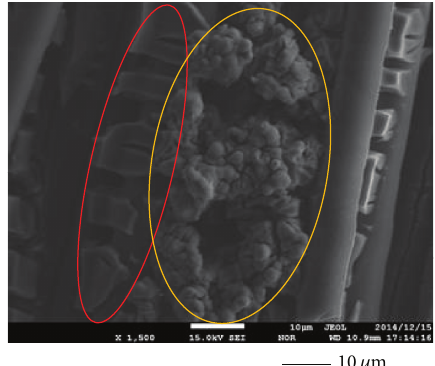
Figure 5: SEM image of Fe/TiO 2 film coated on netlike glass disc.